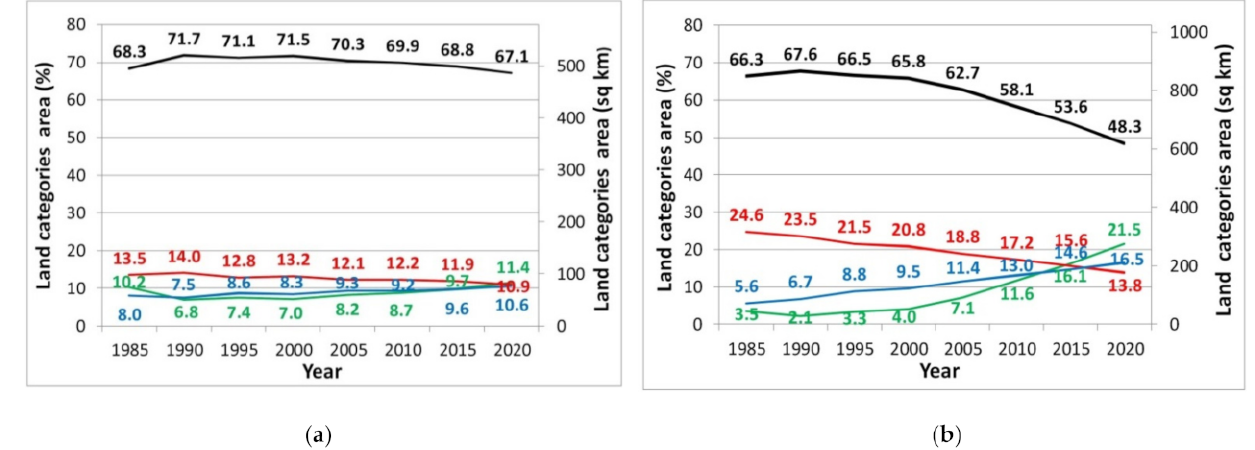
Figure 10. The land categories dynamic within the IAL mask: ( a ) Liozno district (Belarus); ( b ) Rudnya district (Russia). Legend: arable lands (black), grasslands (red), afforested arable lands (green), afforested grasslands (blue).